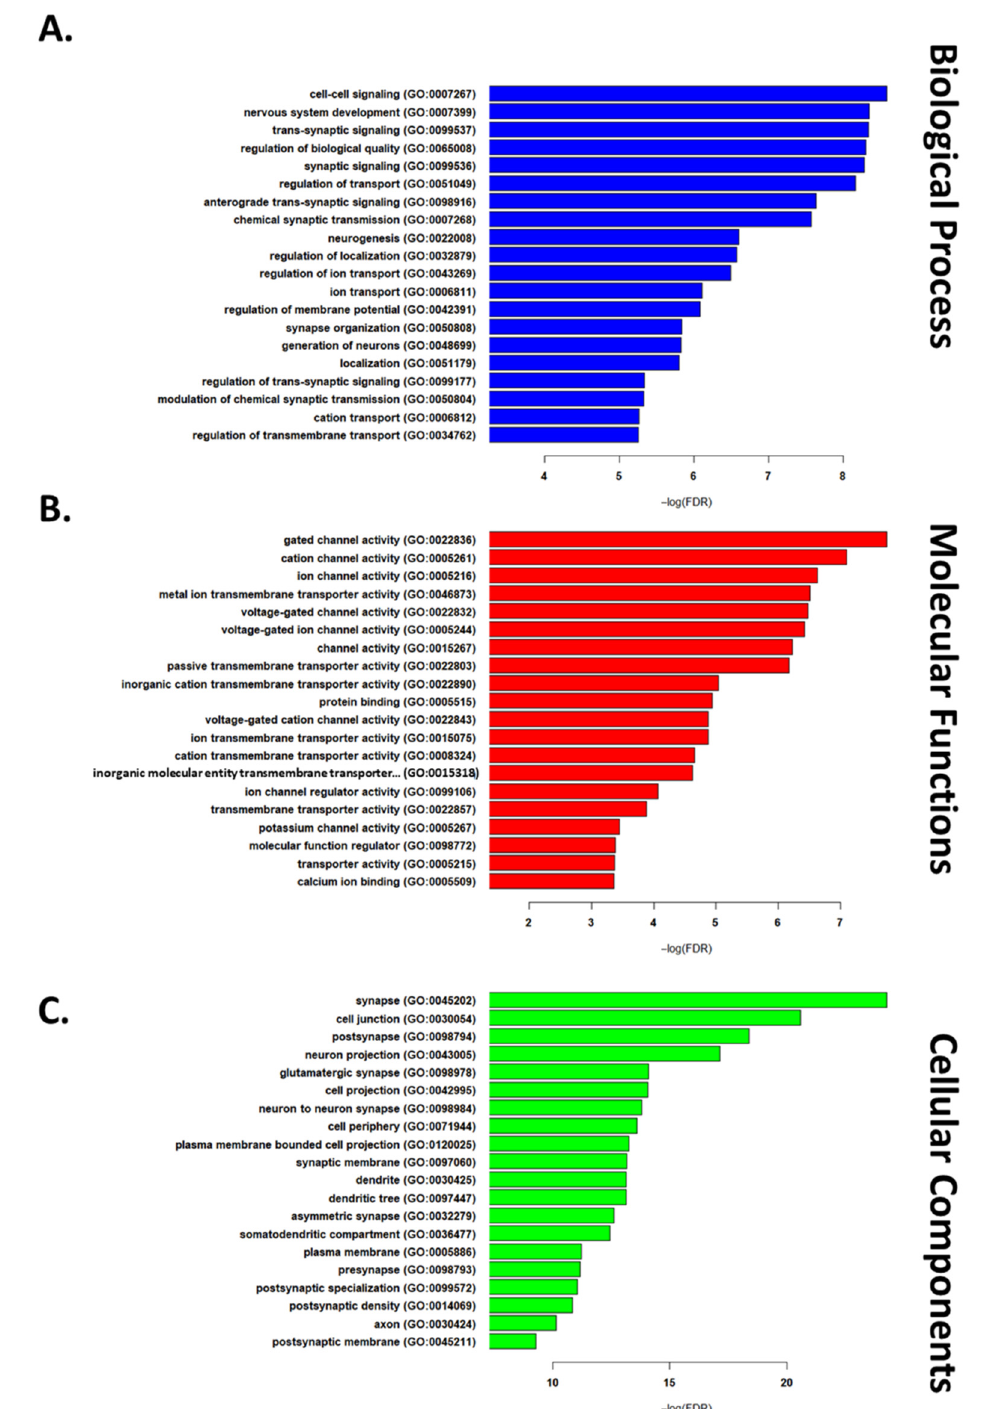
Figure 2. The top 20 GO terms in each of the biological process ( A ), cellular components ( B ), and molecular functions ( C ) domains for downregulated genes (list of all significant terms can be found in Table S9–S11).